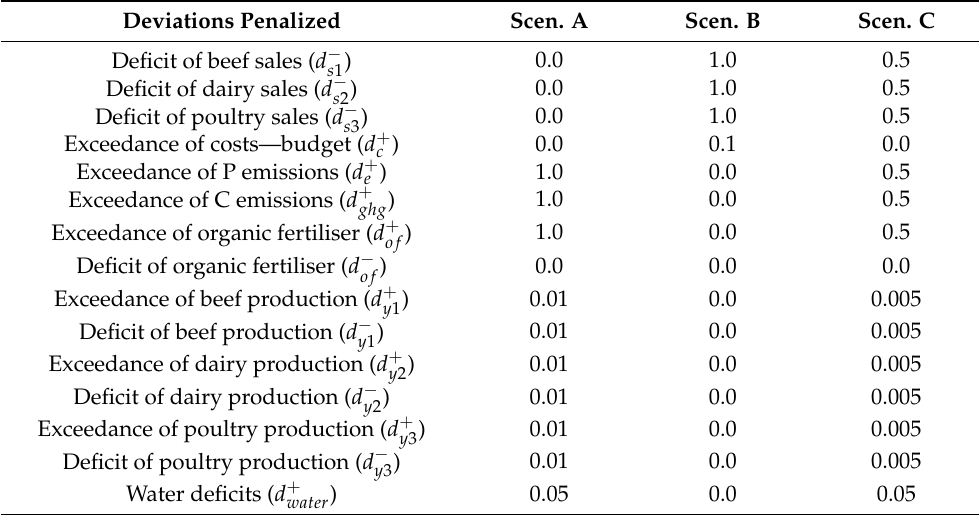
Table 5. Weights assigned per scenario (scale